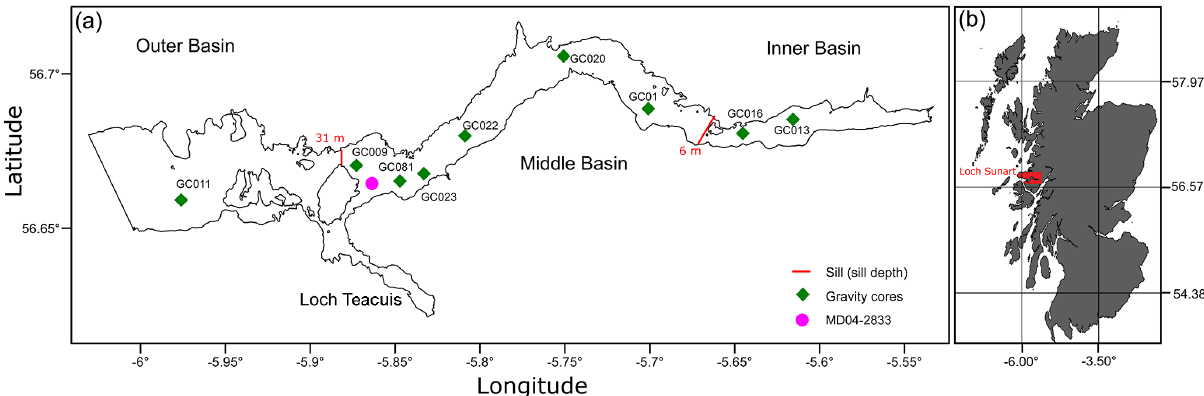
Figure 1. Maps of Loch Sunart illustrating (a) the three basins and the sediment core locations and (b) Loch Sunart in a Scottish context.